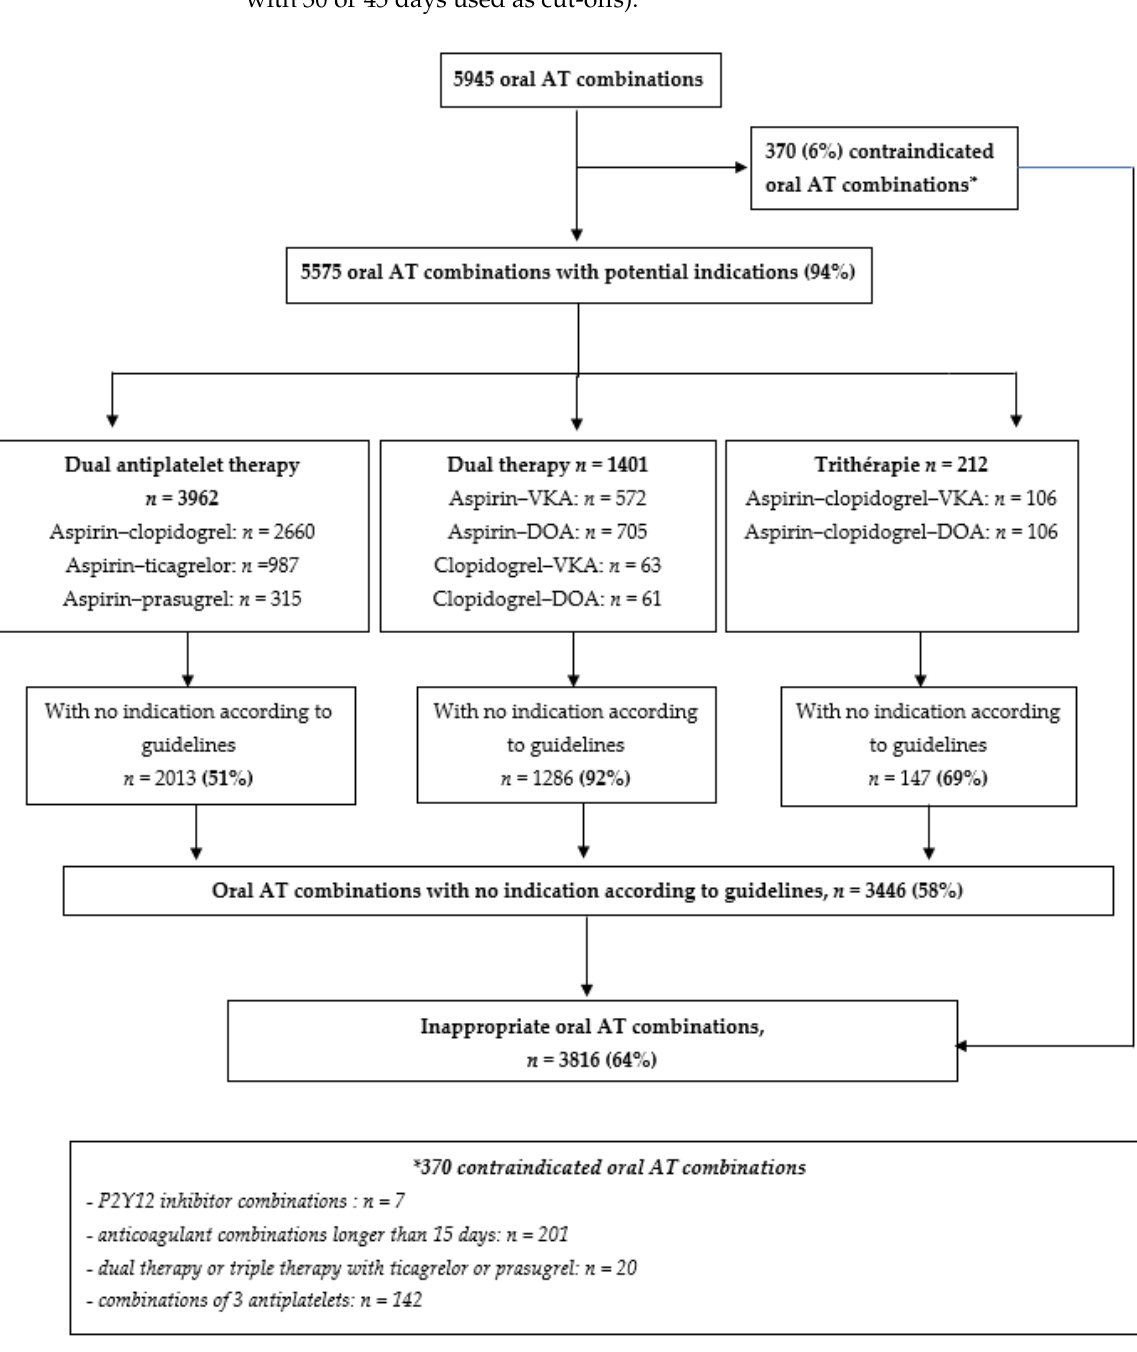
Figure 3. Proportion of inappropriate oral antithrombotic combination. Abbreviations: AT: antithrombotics; DOA: direct oral anticoagulant; VKA: vitamin K antagonist.